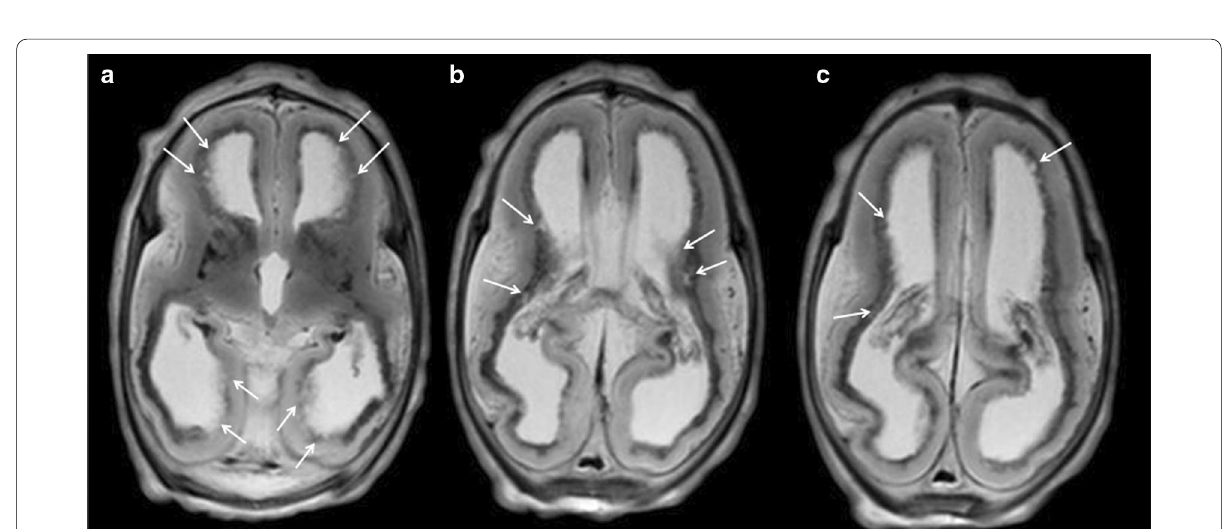
Fig. 8 Cystic periventricular lesions in a 24‑week foetus with elective termination of pregnancy due to CMV infection. a – c Axial T2W MRI showing ventricular dilatation and cystic periventricular lesions